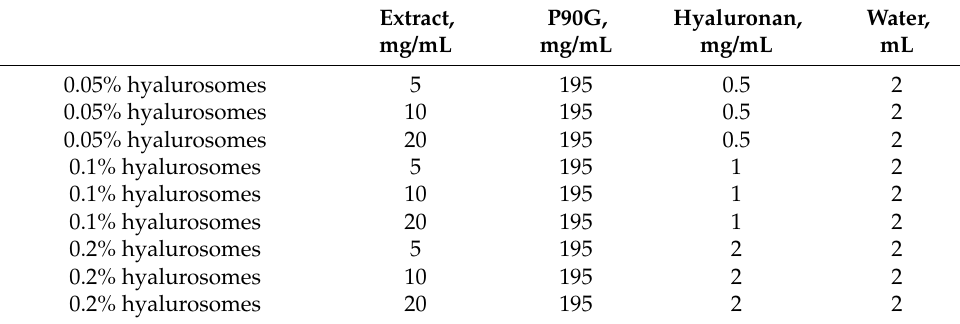
Extract, P90G, Hyaluronan, Water, mg/mL mg/mL mg/mL mL